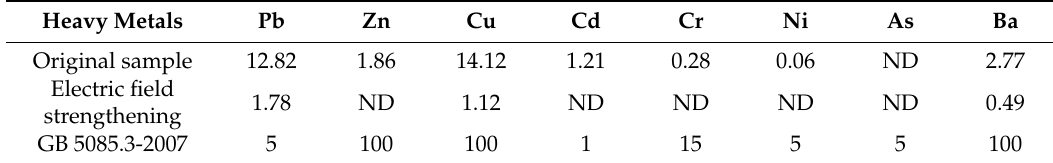
Table 5. Extraction toxicity of treated MSWI fly ash (mg/L).